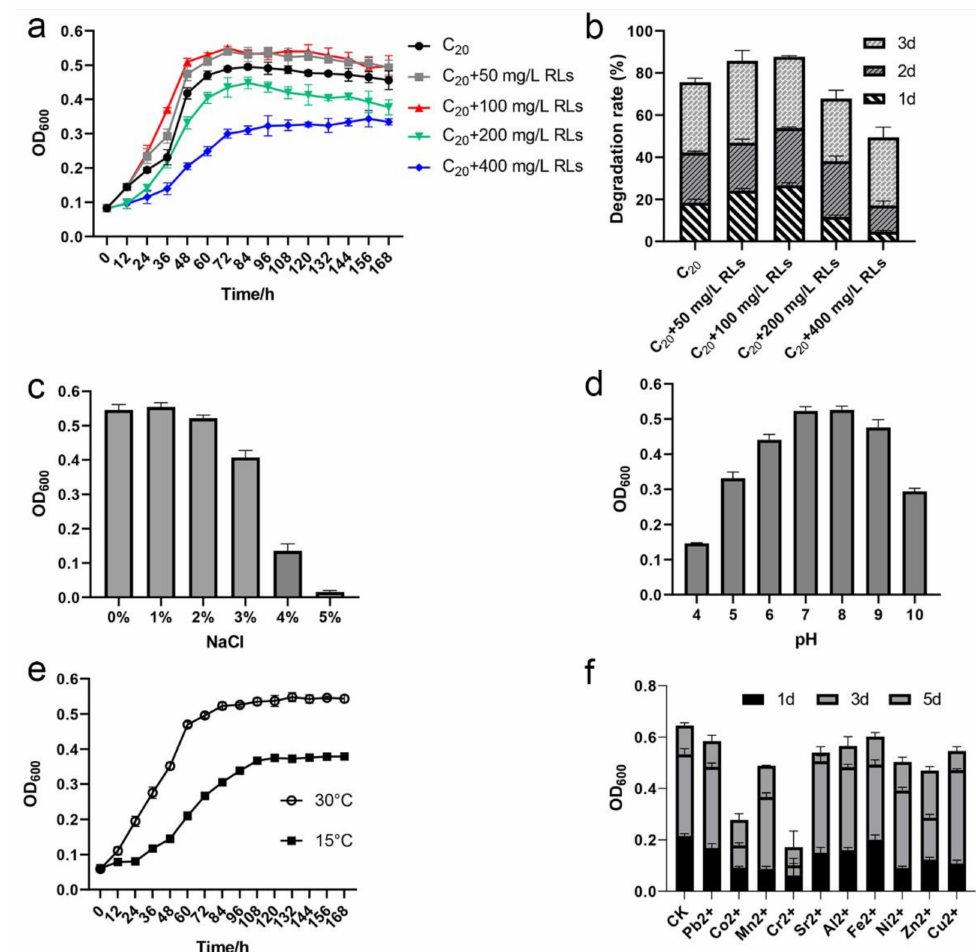
Figure 6. The growth curves of A. pittii sw-1 under various conditions and its alkane degradation rate. ( a ) Growth of A. pittii sw-1 in 500 mg/L C 20 with 0–400 mg/L rhamnolipids (RLs). Strain sw-1 was inoculated in 50 mL of BSM with 500 mg/L C 20 . All flasks were kept at 30 ◦ C for 7 d. The growth was determined by examining OD 600 every 12 h. The daily degradation rate of C 20 for 3 d was measured after adding different concentrations of RLs, and then compared with the degradation rate of the control group without RLs. ( b ) Degradation rate of C 20 with different concentrations of RLs. ( c ) Growth of A. pittii sw-1 in C 20 with 0–5% NaCl. ( d ) Growth of A. pittii sw-1 in 500 mg/L C20 with various pH values (4–10) for 7 d. ( e ) Growth of A. pittii sw-1 in 500 mg/L C 20 with two kinds of temperature (30 ◦ C and 15 ◦ C) for 7 d. ( f ). Growth of A. pittii sw-1 in 500 mg/L C 20 with diverse heavy metals. The concentration of each heavy metal was 100 µ M. Bacterial growth on 1st, 3rd, and 5th d was compared. All experiments were repeated three times. The error bars represent standard